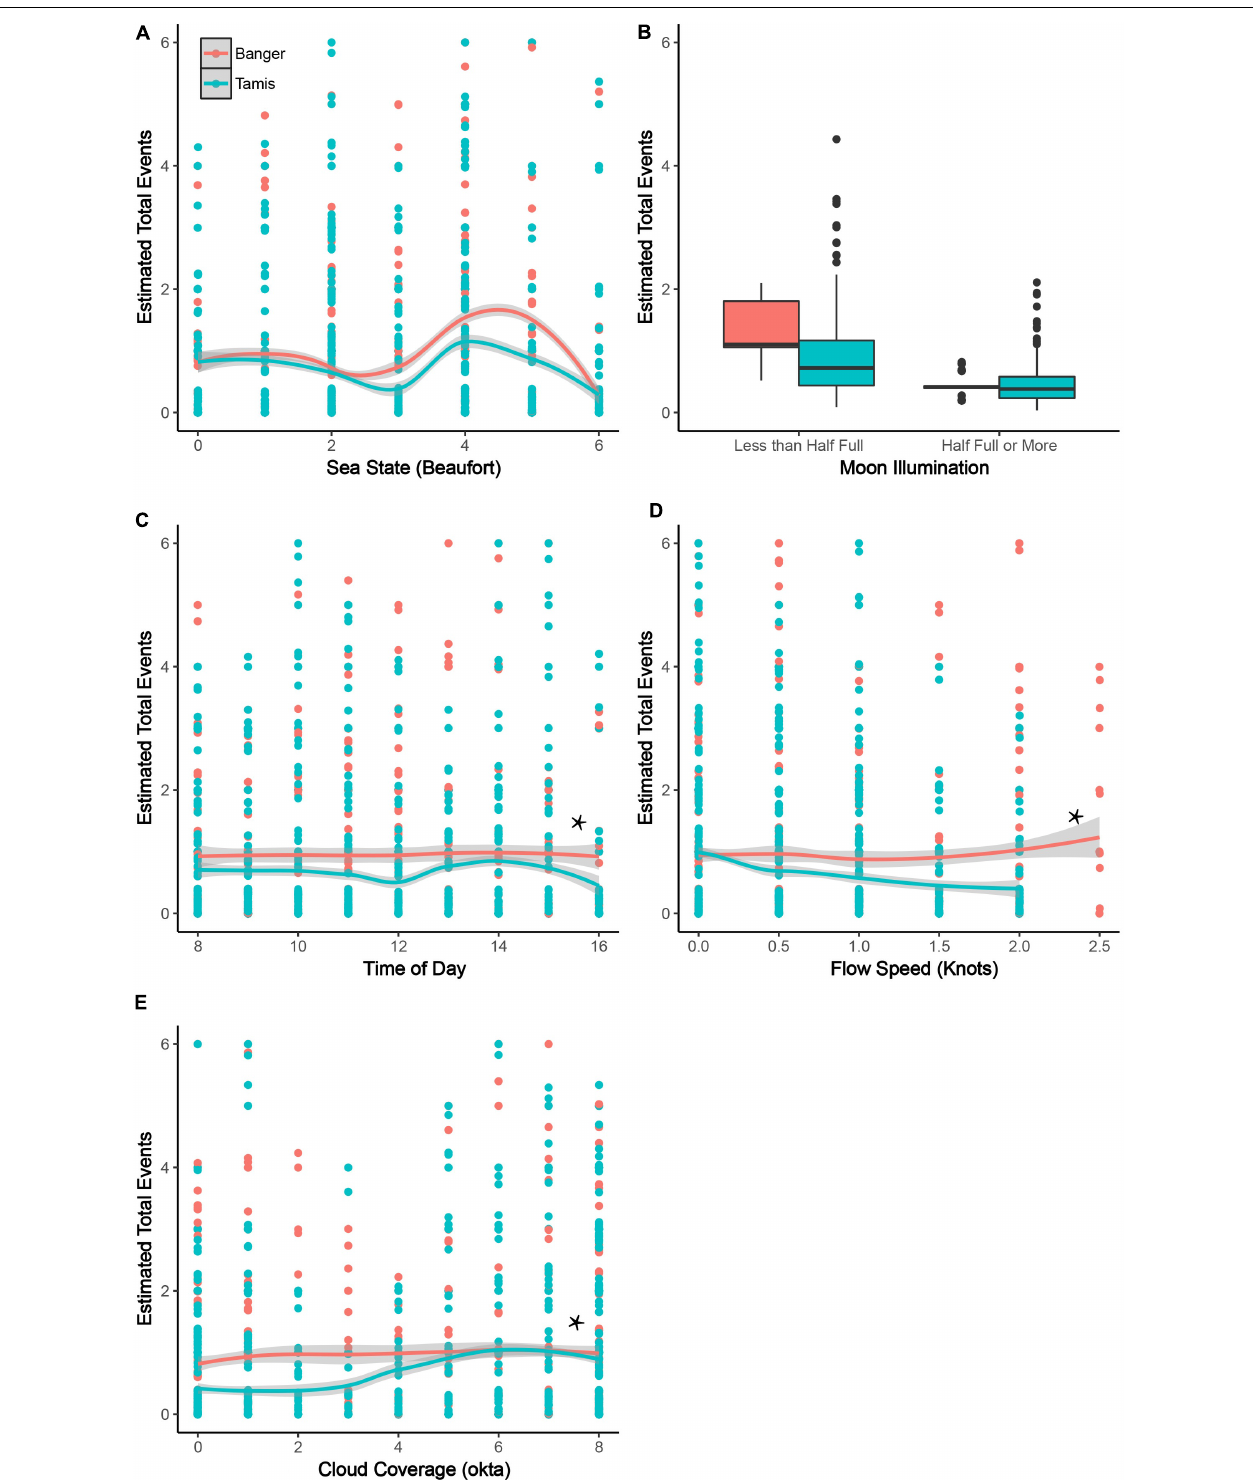
FIGURE 1 | Generalized linear model output – Partial effect of environmental factors on manta presence at the two cleaning stations (Banger-II and Tamis Rock) in the Manta Bowl seamount. Results of the analysis of the interaction between environmental factors and manta cleaning events in Tamis Rock (colored blue) and Banger-II (colored red). Each plot presents the partial contribution of the factor as a predictor of manta cleaning events. Factors in plots (A,B) were found significant in both cleaning stations. Factors in plots (C–E) (marked with Asterisk) were only found significant in Tamis Rock station. In each plot the y -axis represents number of cleaning events witnessed during the state represented in the x-axis. All error bars and ribbons in the graphs represent standard errors; α was set to 0.05.